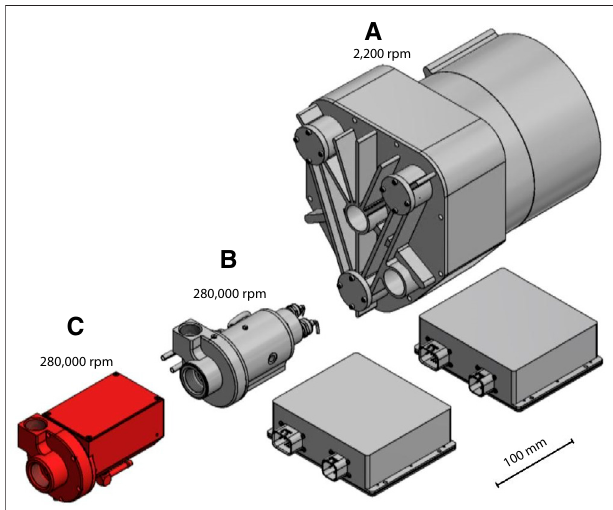
FIGURE 1 | Size comparison of (A) state-of-the-art fuel cell scroll compressor (P32H58N2.25 (Air Squared, 2015)) paired with external inverter (CC-120-1000), (B) high-speed air bearing turbo compressor (CT-17-1000 GB (Celeroton, 2017)) paired with external inverter CC-120-1000, and (C) novel high-speed turbo compressor with integrated inverter described in this paper.